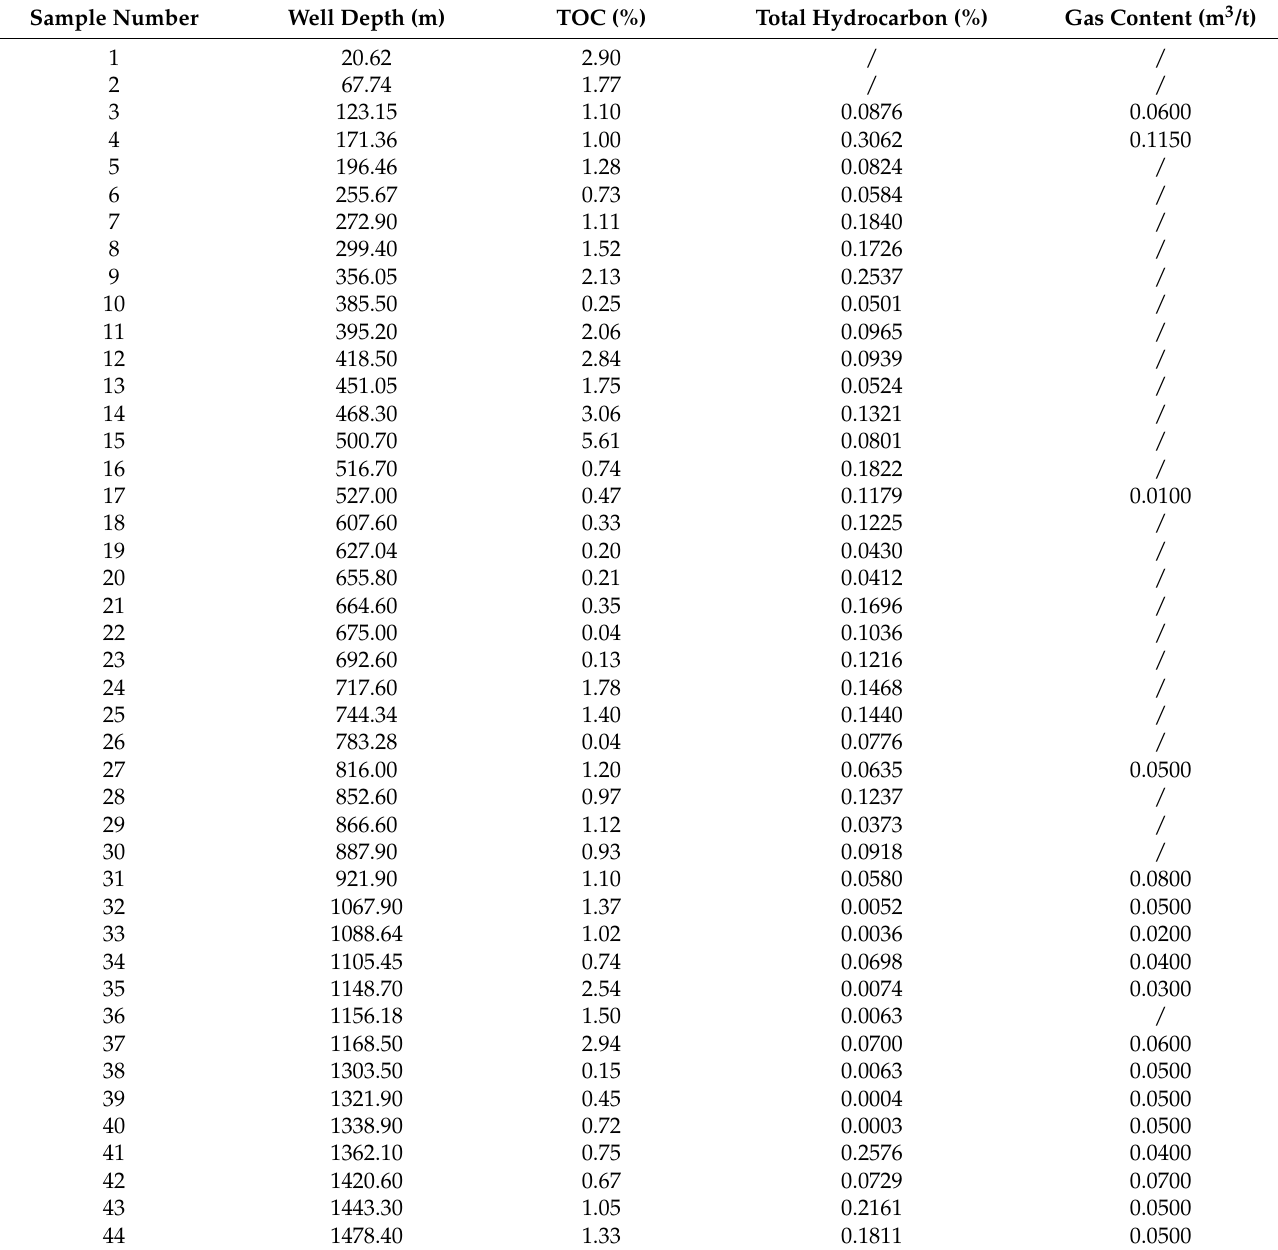
Table 2. The field analysis data of the Galedesi Formation shale in the Tianye 1